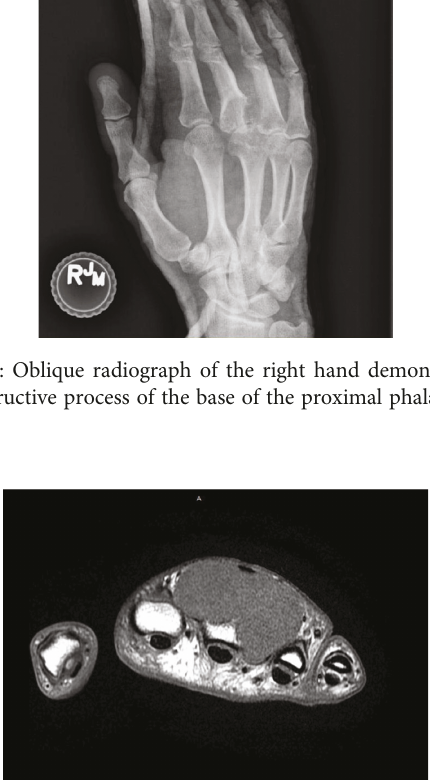
Figure 2: T1 axial MRI image of the right hand demonstrating an expansile destructive mass involving the proximal phalanx of the third digit measuring 3.8 × 2.2 × 3.5cm.